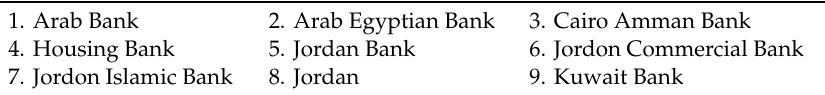
Table 1. List of nine banks chosen for the